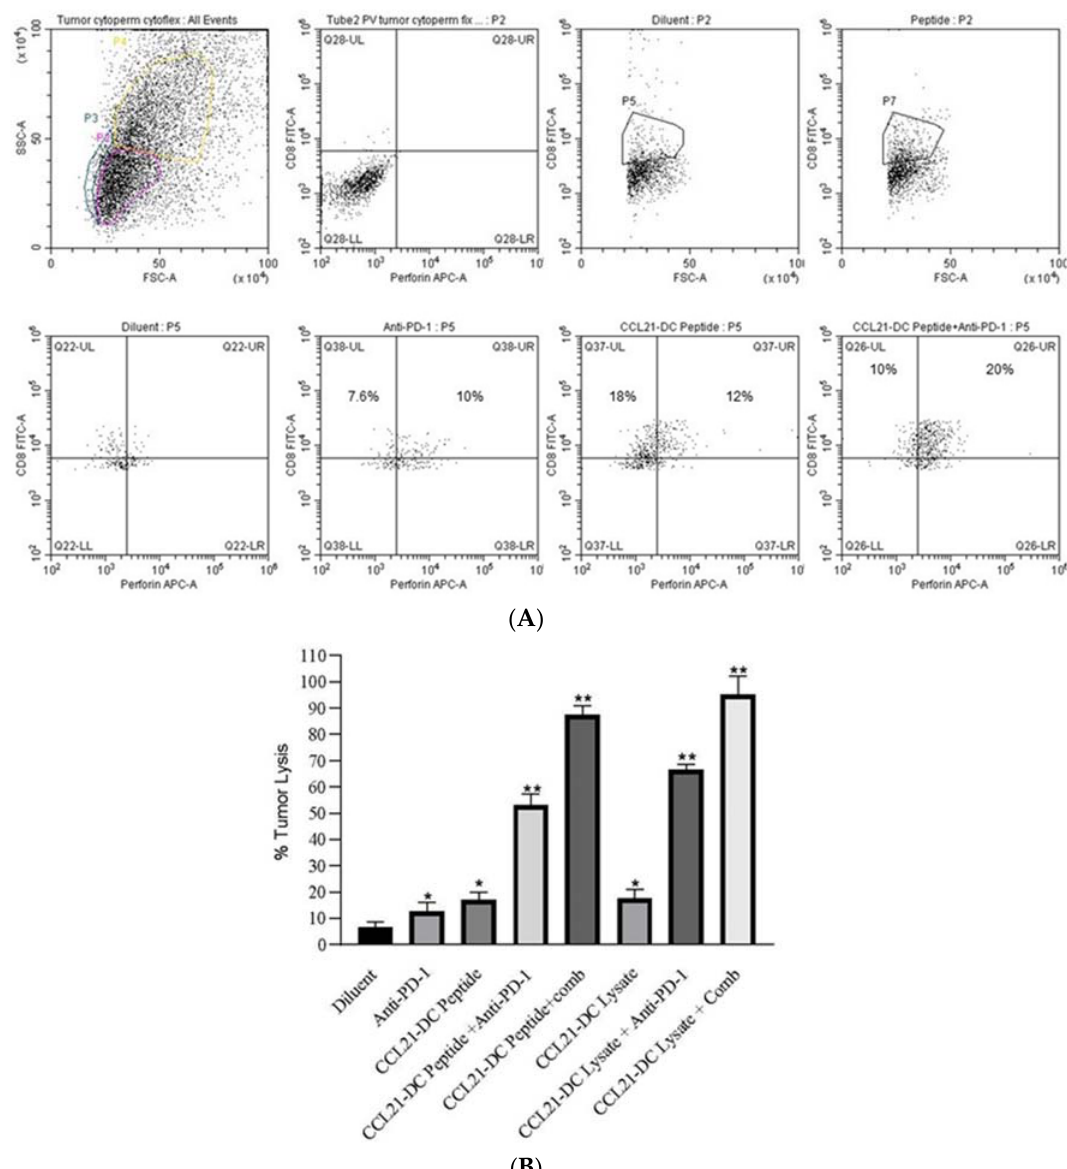
Figure 2C – E: H&E, IHC and IF of tumor microenvironment demonstrated enhance immune infiltrates and reduced tumor burden following combined therapy. Red denotes cytokeratin in tumor and pink denotes perforin in activated CD8 T cells. This is a representative IF figure for the markers cytokeratin, PD-L1, CD4, CD8, perforin and granzyme B. Image analysis of IF staining of tumor sections revealed enhanced CD4 T cells, CD8 T cells, perforin and granzyme B but reduced tumor- specific cytokeratin following therapy (Figure 2E).